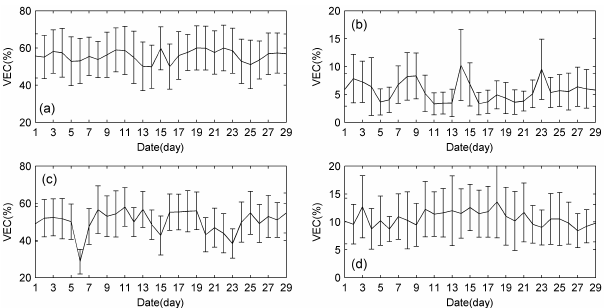
Figure 7. Time series of daily mean and standard deviation of vehi- cle emission contribution rate on NO 2 and PM 2 . 5 concentrations of Beijing main urban areas in July (a, b) and December (c, d) 2013.